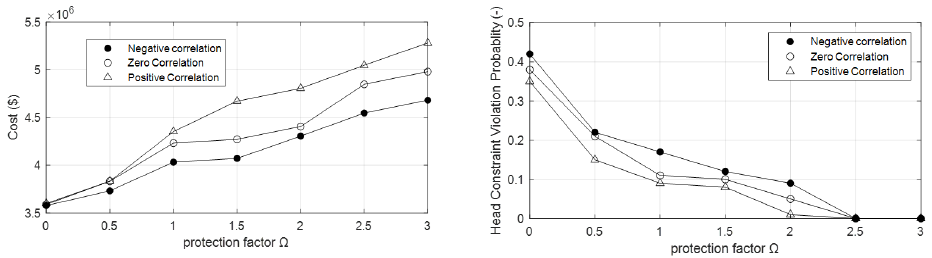
Figure 5. Results of correlated optimization for FOWM network.